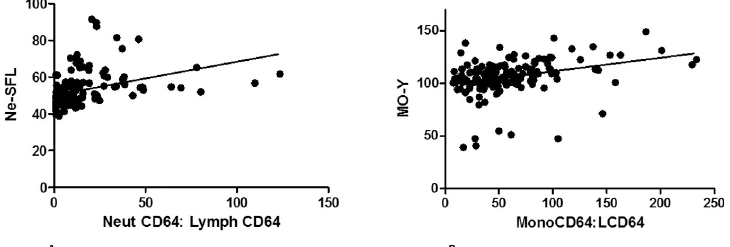
Fig 1. Graphs depicting the linear regression analysis between NE-SFL and nCD64:lCD64 (A) and between MO-Y and mCD64:lCD64 (B).